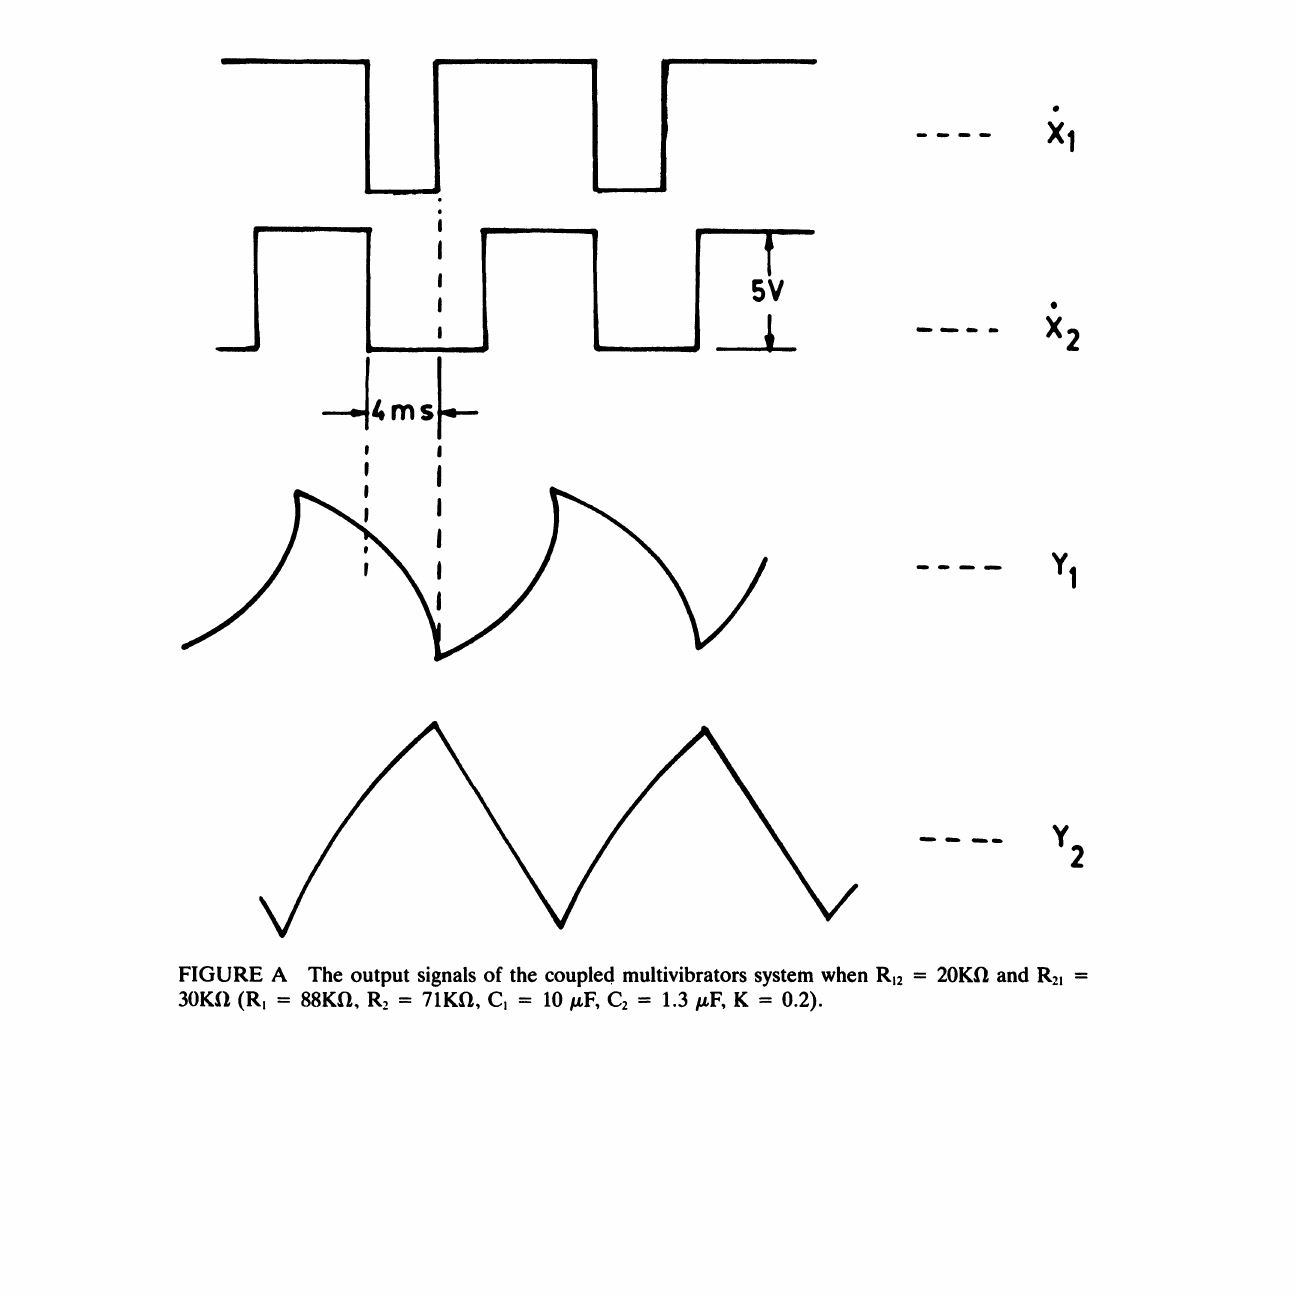
FIGURE A The output signals of the coupled multivibrators system when